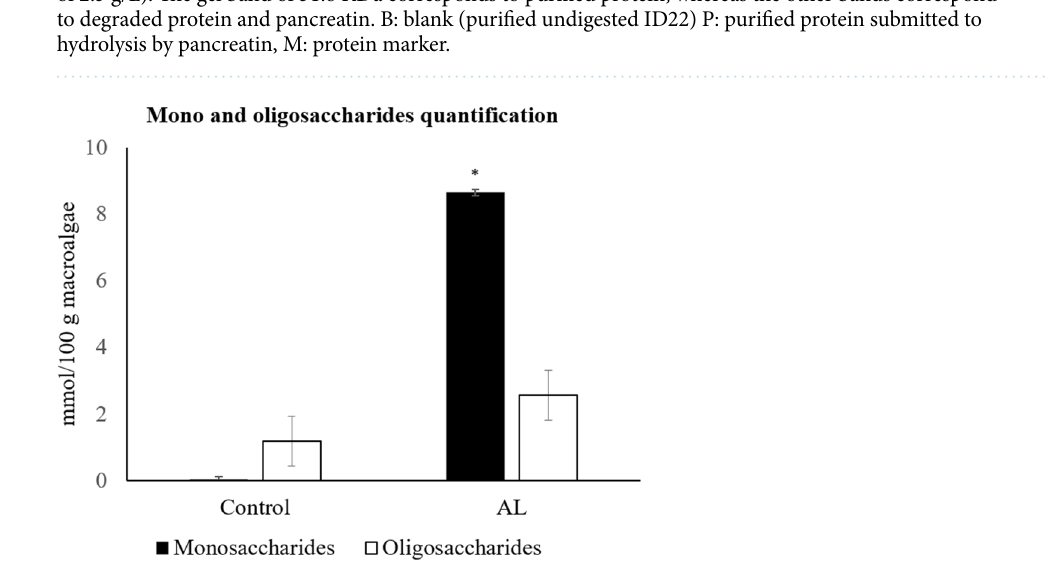
Figure 6. Quantification of released mono- and oligosaccharides for control assay and alginate lyase (AL; ID 22) treatment. Asterisk denotes statistical difference at p <